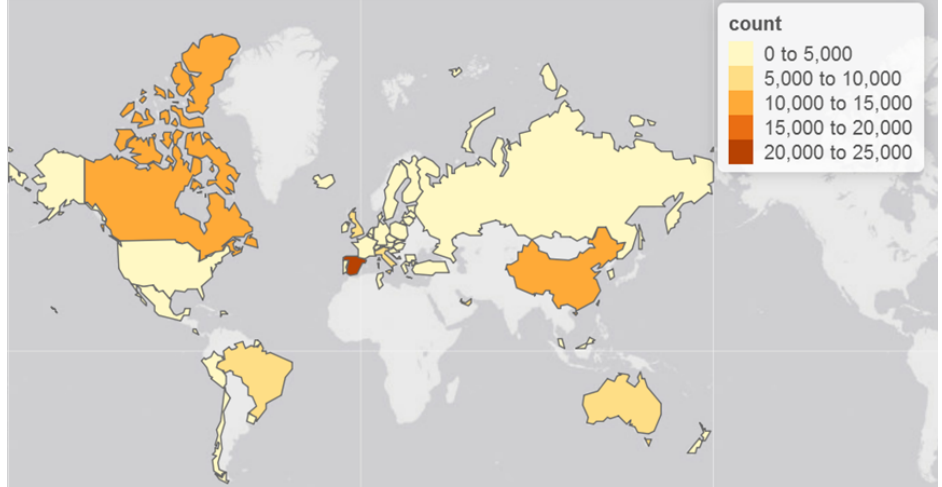
Figure A1. Spatial Distribution of youth respondents count across countries. (Source: The authors own construction; Dynamic web link available at: